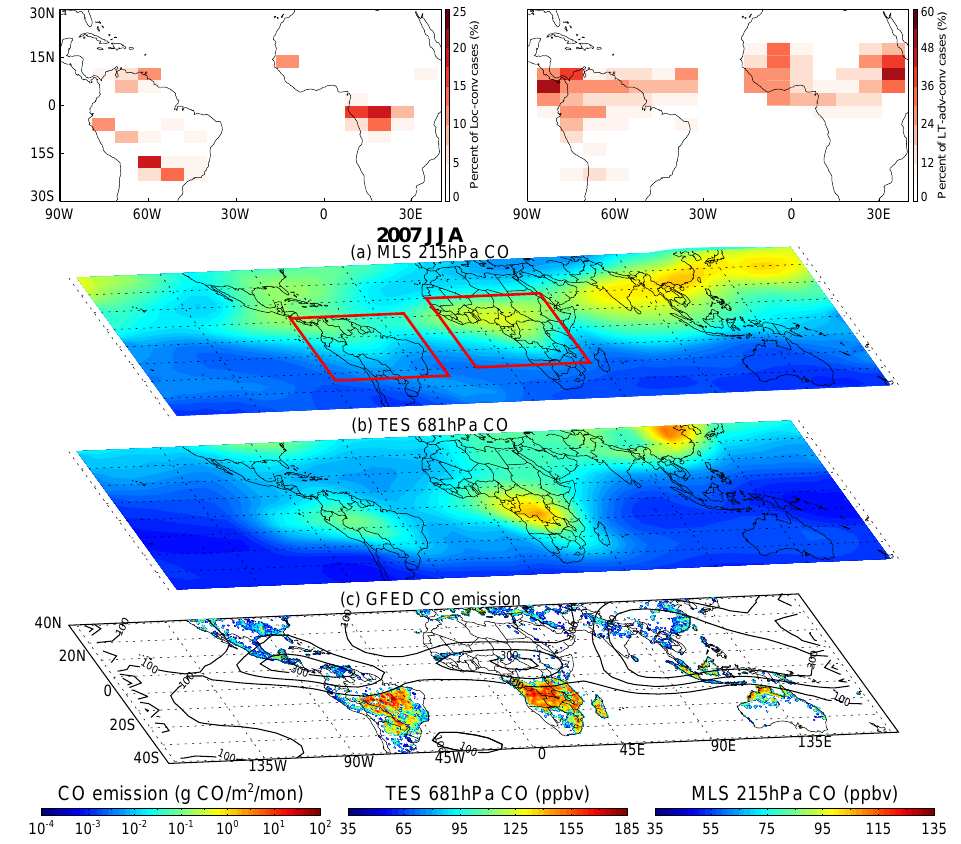
Fig. 6. As in Fig. 4, but for June–August